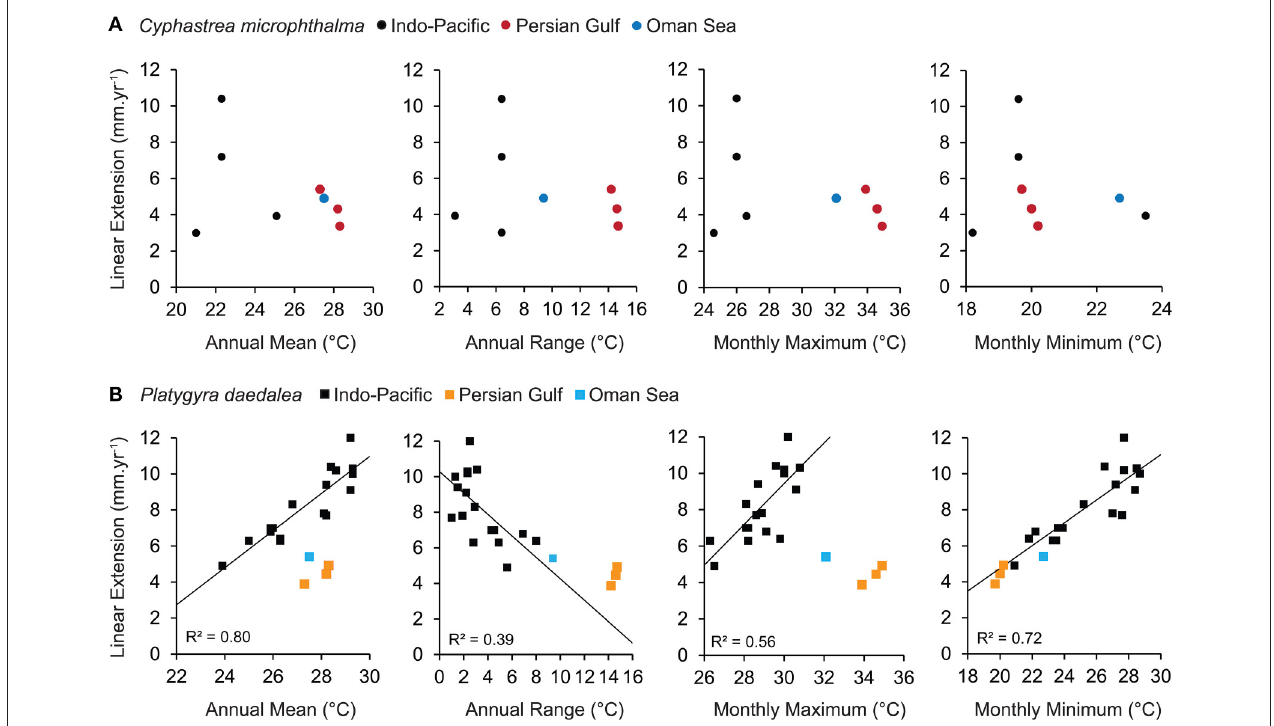
FIGURE 5 | Relationship between linear extension and sea temperature for the corals (A) Cyphastrea spp. and (B) Platygyra spp. Data from the Persian Gulf and Oman Sea in this study are compared to relationships from available records for the wider Indo-Pacific. Relationships between linear extension and sea temperature were only apparent for Platygyra records and are indicated with trend lines and R 2 values.